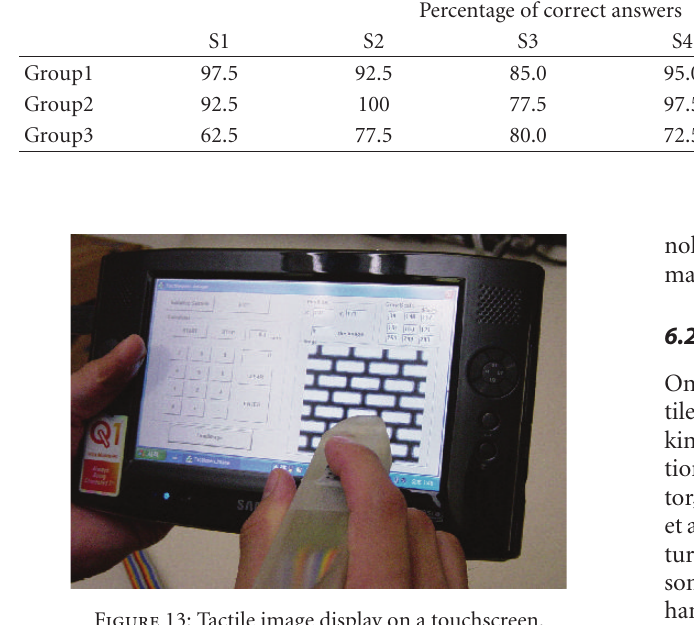
texture display performance of the Ubi-Pen, the image sam- ples from Section 5 were reused. One of five images from one of the groups was displayed on the screen, but hidden from the participant. Instead, the visual representation was of a blank square the same size as the image. When a user rubs against this square, the gray values from the image are pre- sented to the tactile display on the Ubi-Pen. The experimen- tal results are shown in Table 7 and these data verify that the Ubi-Pen and image display scheme are e ff ective. This scheme can be applied to educational programs for children or in- teractive drawing software. In the future, this kind of